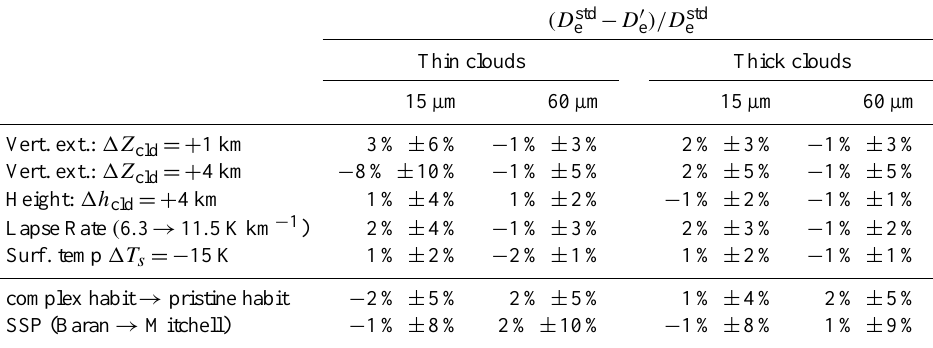
Table 1. Compilation of the uncertainties sources and their influence on the retrieval of the mean ice-crystal diameter D std e . Biases and noise determined as average and standard deviation of (D std e − D 0 e )/D std e distributions from retrieval statistics over 2yr. For thin clouds (cid:15) cld ∈ [ 0 . 3 , 0 . 4 ] and for thick clouds (cid:15) cld ∈ [ 0 . 7 , 0 . 8 ] . D e ’ 15 µm corresponds to D e ∈ [10 µm, 20 µm] and D e ’ 60 µm corresponds to D e ∈ [50 µm, 70